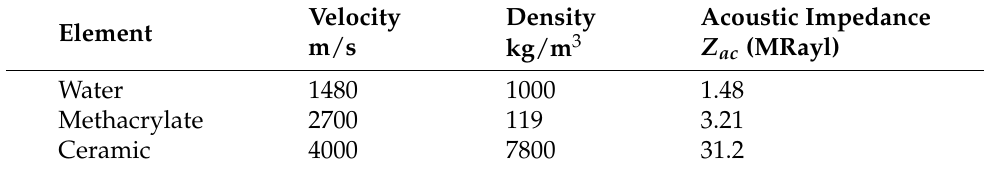
Table 1. Velocity, density, and acoustic impedance values of the elements tested in the experiment.